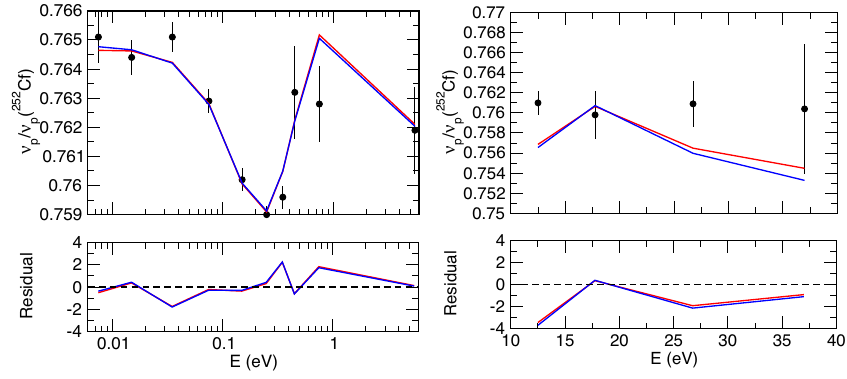
Figure 4. Comparison between the fits to the ν p experimental data from Gwin using Γ γ f from Trochon et al. (red line) and Lynn et al. (blue